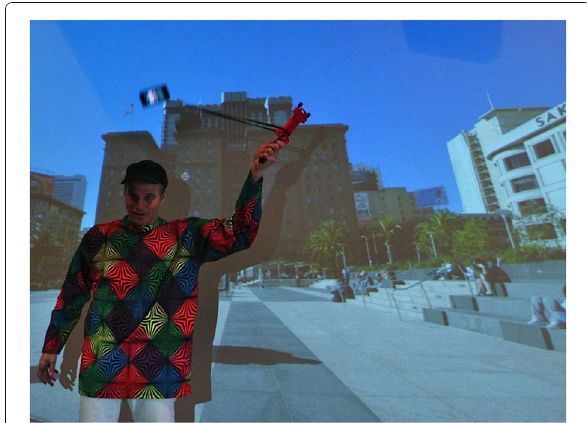
Fig. 10 PoI Poi : Point-of-interest poi panning projected panoramas, whirling-controlled situated panorama as locative media. The view emulates that which would be captured by a radial (outward facing) camera swung on its cable. The perspective can also be turned inside-out, modulating the orientation of an object movie, a turno, emulating an inspection or spin-around gesture